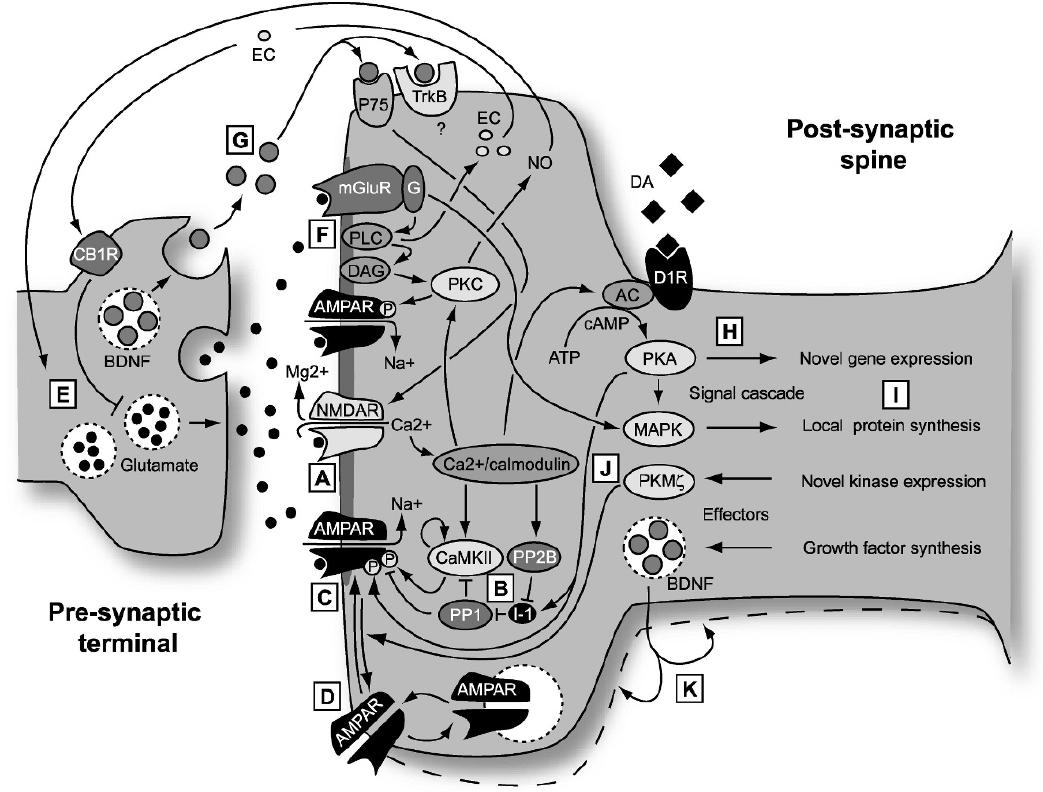
Figure 2 - LTP and LTD: Schematic of molecular mechanisms. ( A ) The induction of canonical forms of both LTP and LTD is triggered by activation of the NMDA class of glutamate receptor. This ionotropic receptor detects the coincidence of presynaptic and strong postsynaptic activity by a mechanism that involves both the binding of transmitter and depolarization-induced repulsion of the Mg 2 + ions that block its ionophore at near-resting membrane potentials. In its unblocked state Ca 2 + ions are able to permeate the channel, gaining access to Ca 2 + -dependent processes in the spine and triggering synaptic plasticity. ( B ) Ca 2 + binds to Ca 2 + /calmodulin which, in turn activates numerous kinases and phosphatases, including CaMKII, PKC and Calcineurin (PP2B) directly and PKA and PP1 indirectly. The balance of kinase and phosphatase activity depends on the concentration and temporal profile of the postsynaptic Ca 2 + transient (including Ca 2 + released from intracellular stores). The Ca 2 + transient determines the polarity of the induced plasticity, with low and prolonged Ca 2 + transients inducing LTD and brief, steeper transients inducing LTP. ( C ) One means by which LTP is expressed is through phosphorylation of the AMPA receptor, an ionotropic glutamate receptor that mediates baseline chemical transmission at excitatory synapses in the CNS. Phosphorylation by CaMKII enhances the conductance of these channels. LTD, by contrast, results, in part, from the dephosphorylation of the AMPA receptor by phosphatases. ( D ) Trafficking of AMPA receptors plays a major role in the expression of LTP and LTD by increasing or decreasing the number of receptors in the postsynaptic membrane. ( E ) Presynaptic mechanisms leading to a sustained increase in the probability of transmitter release also contribute to the expression of LTP. The relative contributions of pre- and post-synaptic mechanisms may vary at different times after induction and also across different classes of synapse. Since induction of LTP and LTD is controlled by the post-synaptic NMDA receptor, any presynapic component of expression requires a retrograde messenger that can signal to the pre-synaptic terminal that coincidence has occurred. Two candidates are nitric oxide (NO) and endocannabinoids (EC). ( F ) A second form of LTD that has been much studied is dependent on group 1 metabotropic glutamate receptors (mGluR). Glutamate binding to this receptor initiates a signal cascade, involving the breakdown of the membrane lipid PIP 2 by phospholipase C (PLC) to the important signaling molecules IP 3 , which releases Ca 2 + from Ca 2 + stores (not shown) and diacylglycerol (DAG), which leads to the activation of the calcium sensitive kinase PKC. This enzyme then phosphorylates the AMPA receptor but in such a manner that the conductance is reduced. An offshoot is the production of NO. ( G ) Brain-derived neurotrophic factor (BDNF) plays a complicated role in both LTP and LTD and contributes in different ways to short-term and long-term plasticity. ( H ) Longer- lasting ‘late’ forms of LTP and LTD, persisting for more than a few hours, require the synthesis of new proteins, either through novel gene transcription or through initiation of local translation of existing transcripts. Novel gene expression requires signaling to the nucleus from newly potentiated or depressed synapses. A major player in this process is the cAMP-dependent signaling cascade initiated by calcium influx and involving adenylyl cyclase (AC) and cAMP-dependent kinase (PKA), which also acts directly on the AMPA receptor in LTP expression. Catecholaminergic modulatory input plays a major role in determining the longevity of LTP and LTD, through interaction with AC which increases levels of cAMP and thereby activates PKA. PKA then sets in action a chain of signals that leads to the expression of new transcripts which, in turn are translated into proteins contributing to the long-term expression of synaptic plasticity. This signaling pathway has been a major recent target of attempts to find nootropic substances. ( I ) There are parallel signaling pathways, involving mitogen activated protein kinases (MAPK), that also result in the synthesis of new proteins. However, in this case existing transcripts are locally translated into proteins, without further requirement for nuclear signaling. The MAPK pathway is strongly implicated in mGluR-dependent LTD. ( J ) One newly synthesized protein that acts as a maintenance mechanism for late LTP is PKM f . This remarkable kinase comprises the active subunit of PKM, an isoform of PKC, that is now known to maintain the presence of AMPA receptors inserted during LTP induction, and thereby maintain LTP. Inhibition of this kinase can erase LTP and memory many days after induction. ( K ) Finally, BDNF can also play a second role in synaptic plasticity, as a newly synthesized product that alters the structure of the synapse to enforce long-term changes in synaptic